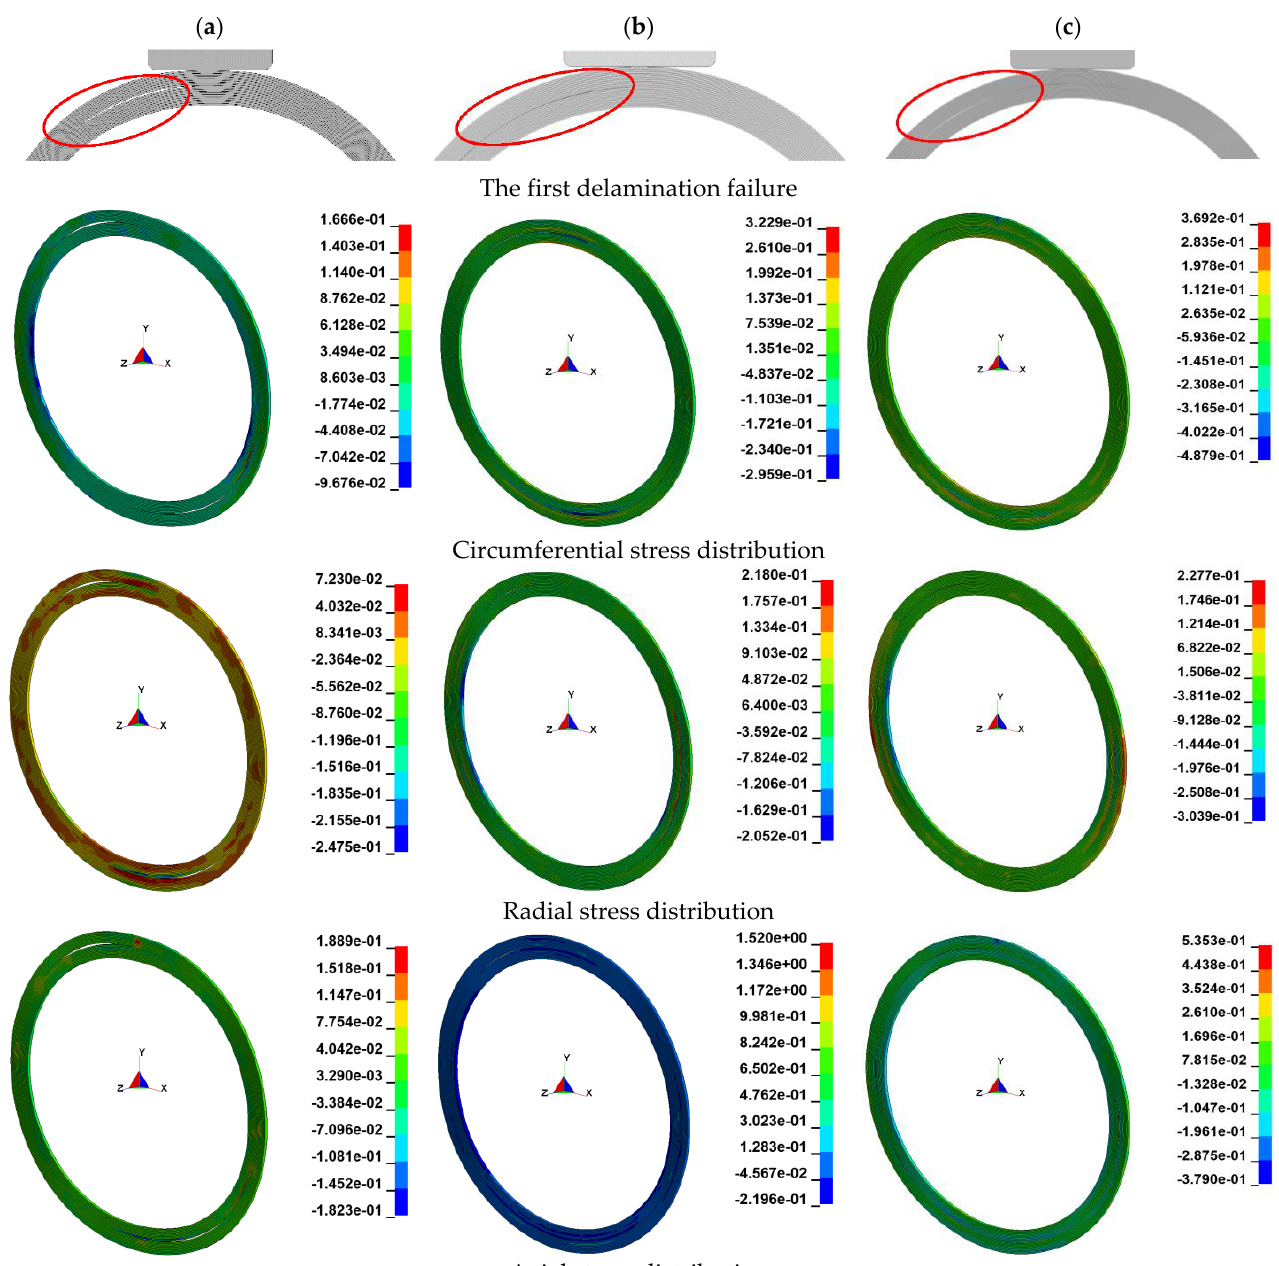
Figure 13. Schematic diagram of the first delamination failure position under different laying meth-